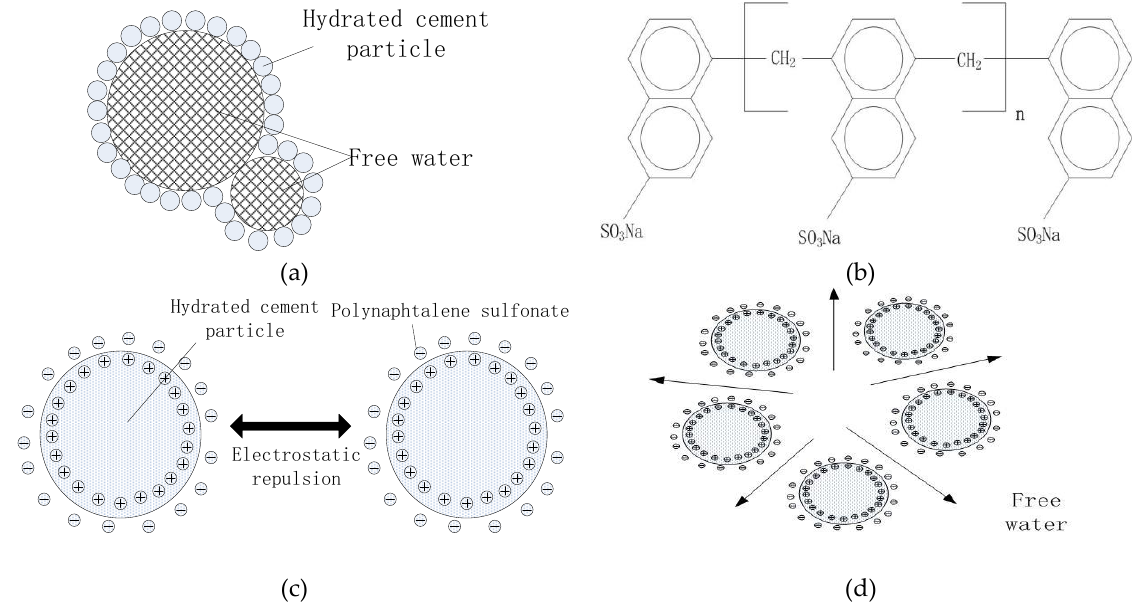
Figure 10. Physico-chemical mechanism of the effect of polynaphtalene sulfonate on the consistency of CPB: ( a ) flocculent structure, ( b ) chemical structure of polynaphtalene sulfonate, ( c ) electrostatic repulsion effect and ( d ) destruction of the flocculent structure.